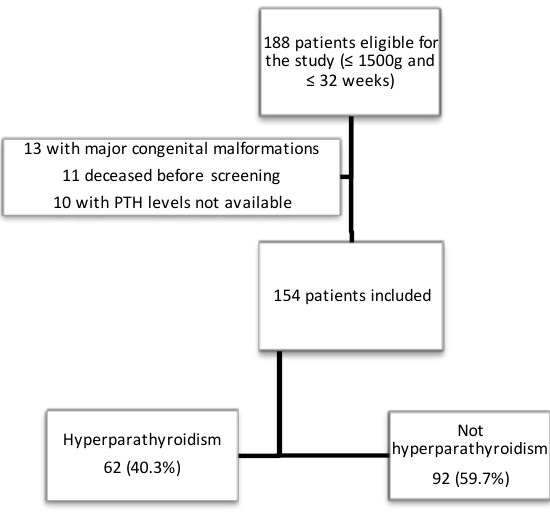
Figure 1. Flow-chart depicting the recruitment of the cohort. The mean gestational age was 29.7 ± 2.07 weeks and mean birth weight was 1165.62 ± 259.72 g. The mean age at which MBD screening was performed was 15.68 ± 2.10 days. Of the patients studied, 62 (40.3%) presented with HPTH, of which 14 cases (9.1%) were classified as severe HPTH. The main perinatal characteristics and outcomes are described in Table 1. The data corresponding to the biochemical MBD screening values are reflected in Table 2. Table 1. Perinatal characteristics and main outcomes of the study cohort.